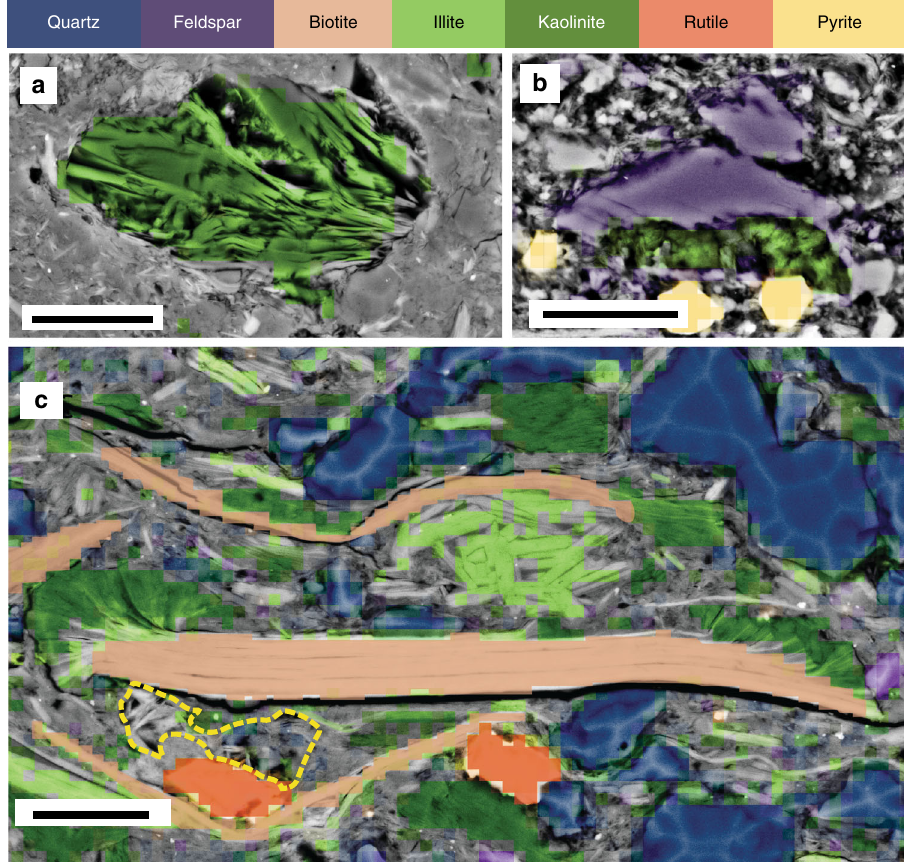
Fig. 5 SEM backscatter images overlain by a Nanomin mineral map illustrating mineral replacement by kaolinite and illite. a Only kaolinite selected in the mineral map layer overlay showing euhedral kaolinite crystals formed within a 40 µ m void most likely formed by feldspar dissolution (from the Urapunga-4 core). b albite, pyrite, and kaolinite selected in the mineral map overlay showing partial dissolution of a 20 µ m feldspar crystal with authigenic kaolinite forming within the mouldic porosity. The boundaries of the minerals identi fi ed by Nanomin mineral mapping and the characteristic shapes of the minerals evident in BSE provide qualitative sense of the precision and accuracy mineral assignments (from the Walton-2 core). c A 70 µ m biotite fl ake with alteration of the ends to kaolinite and illite. Illite replacement of smaller detrital mica minerals including a fan of small 2 – 4 µ m crystals forming a fl occule squeezed between the two large mica fl akes. Detrital quartz grains sutured together by quartz overgrowth, and detrital rutile also evident. Dashed yellow line outlines an area of secondary porosity formed by feldspar dissolution with hairy, authigenic illite/smectite forming within it (from the Lady Penhryn-2 core). Scale bar = 10 μ